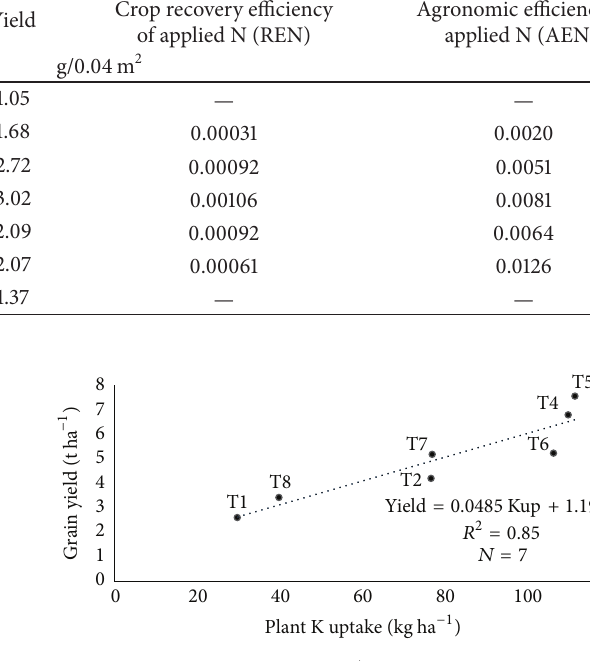
Figure 4: Relationship between K + uptake and grain yield under different treatments, where Kup = potassium